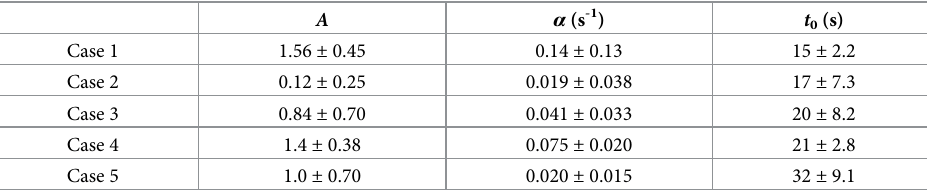
Table 2. Parameter values for empirical model of tracer concentration in